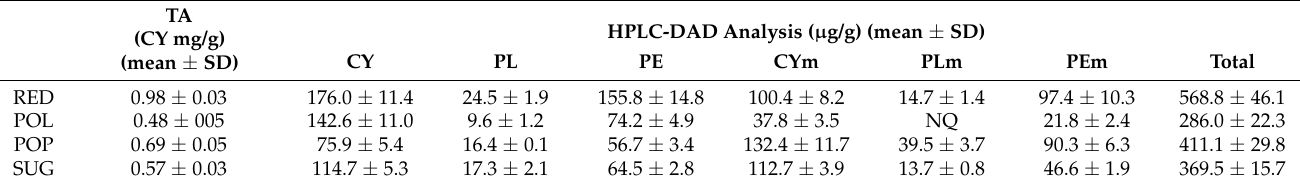
CY: cyanidin-3- O -glucoside, PL: pelargonidin-3- O -glucoside, PE: peonidin-3- O -glucoside, CYm: cyanidin-3-O-(6 (cid:48)(cid:48) -malonyl-glucoside), PLm: pelargonidin-3- O -(6 (cid:48)(cid:48) -malonyl-glucoside), PEm: peonidin-3- O -(6 (cid:48)(cid:48) -malonyl-glucoside), NQ: not quantifiable <LOQ (5 µ g/g). RED: Reduno, POL: Polenta, POP: Pop, SUG: